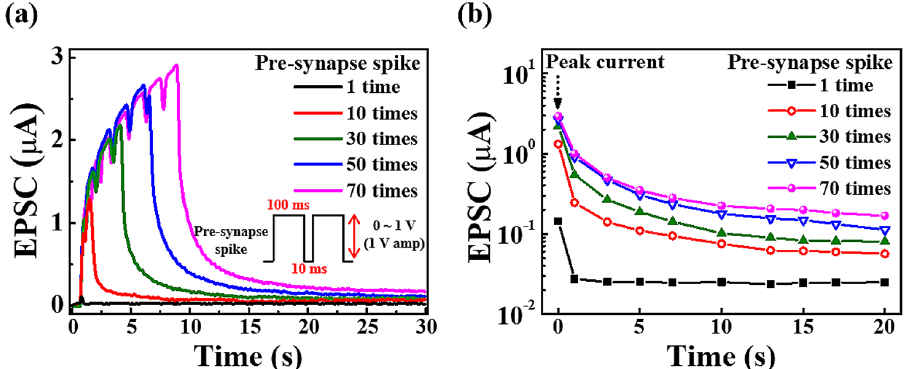
Figure 7. ( a ) EPSC response according to the number of pre-synaptic stimulus spikes (1 V, 100 ms). ( b ) The decay of the EPSC stimulated by a different number of pre-synaptic gate pulses.